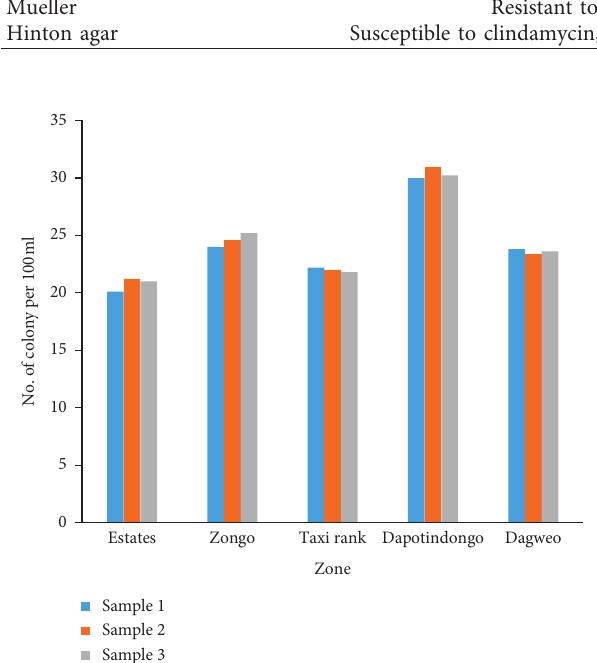
Figure 4: Proximate analyses of Zn, Cd, and Pb by atomic ab- sorption